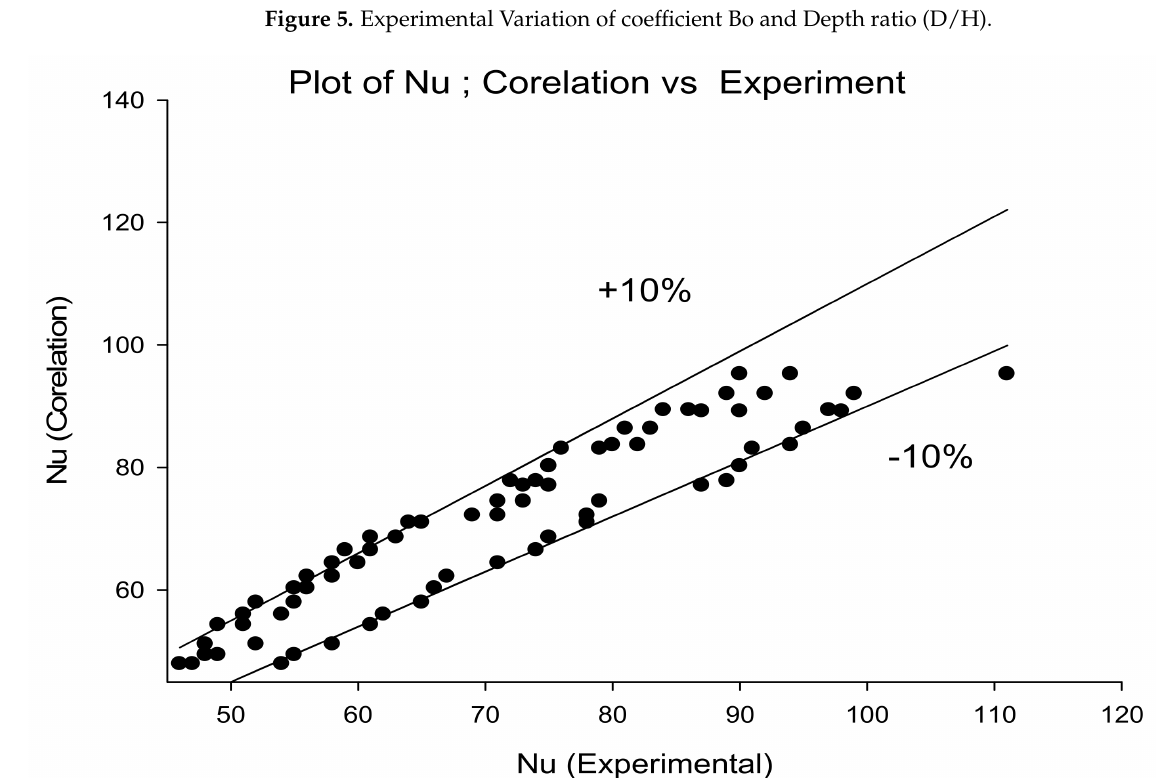
Figure 6. Experimental Variation of correlation and Nusselt